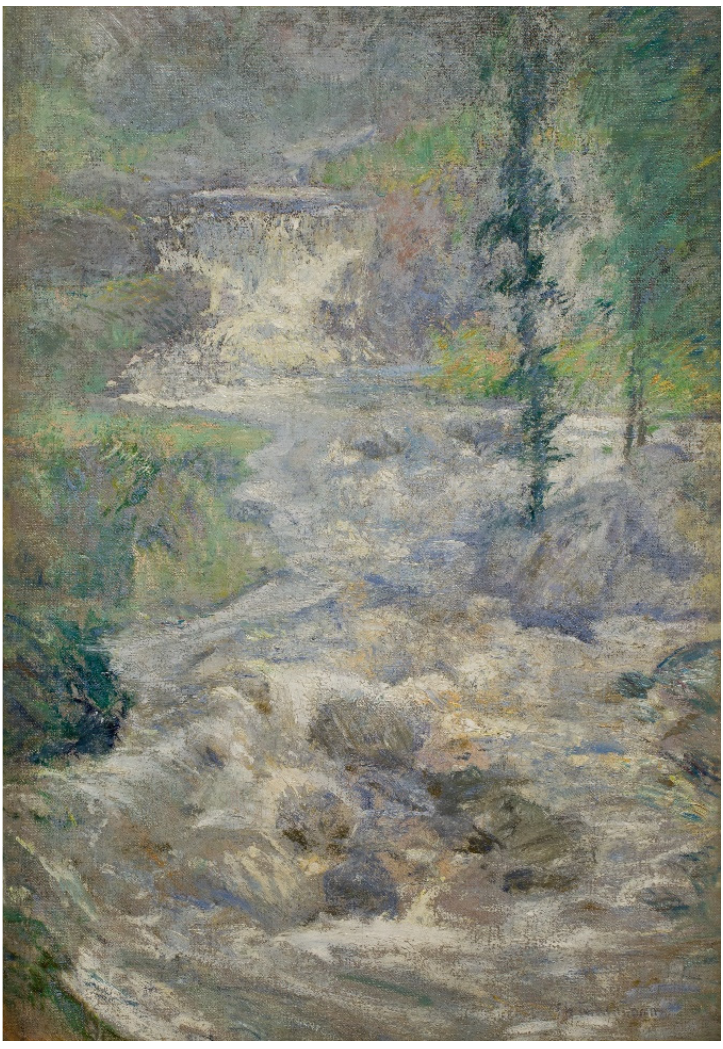
Figure 2. John Henry Twachtman, The Rainbow’s Source , ca.1890–1900, oil on canvas, 91.4 × 64.1 cm, Saint Louis Art Museum, museum’s purchase, 124:1921.